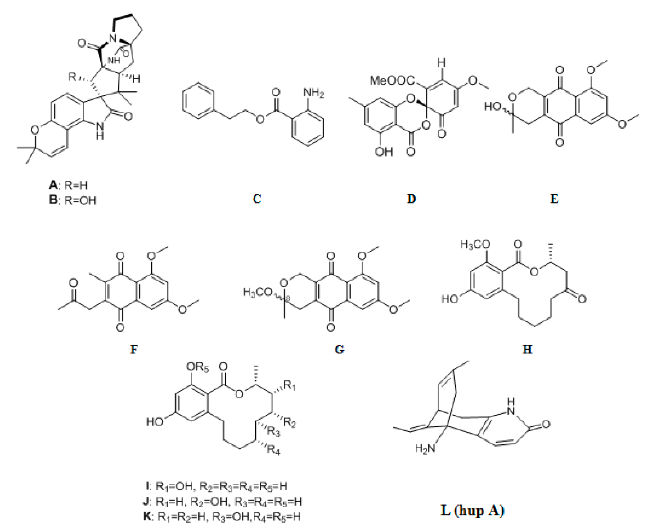
Figure 13. Chemical structures of known compounds. Compound 229 was tested for in vitro antimicrobial activity against 2 bacteria B. sub- tilis (ATCC 23857), and E. coli (ATCC 67878). Chloramphenicol was the antibacterial positive control. 229 showed modest antibiotic activity to E. coli with an MIC value of 100 µ g/mL